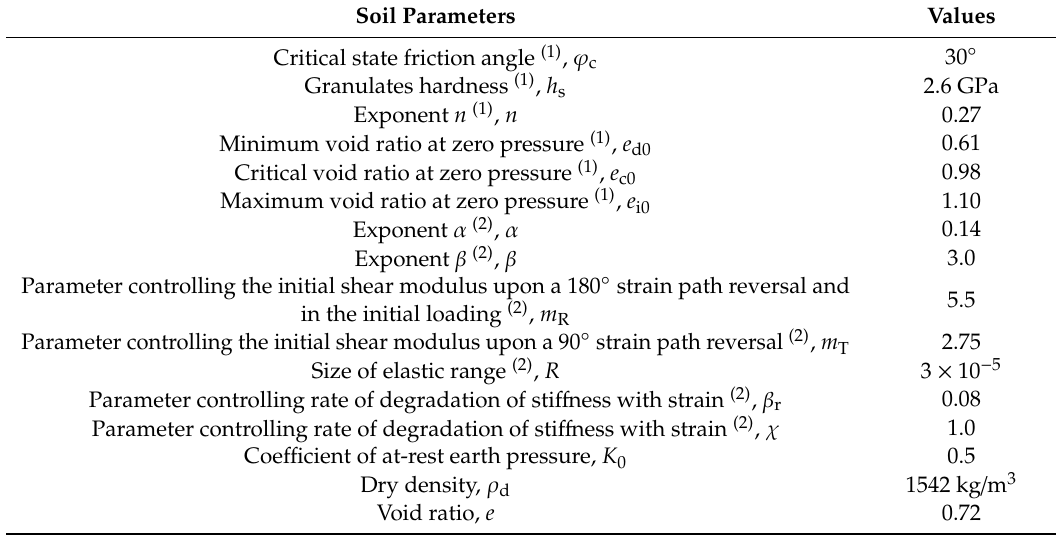
Table 1. Soil parameters adopted in the hypoplastic